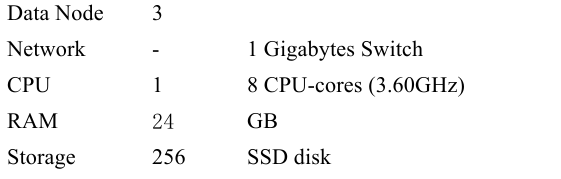
Table 2. Cluster hardware configuration